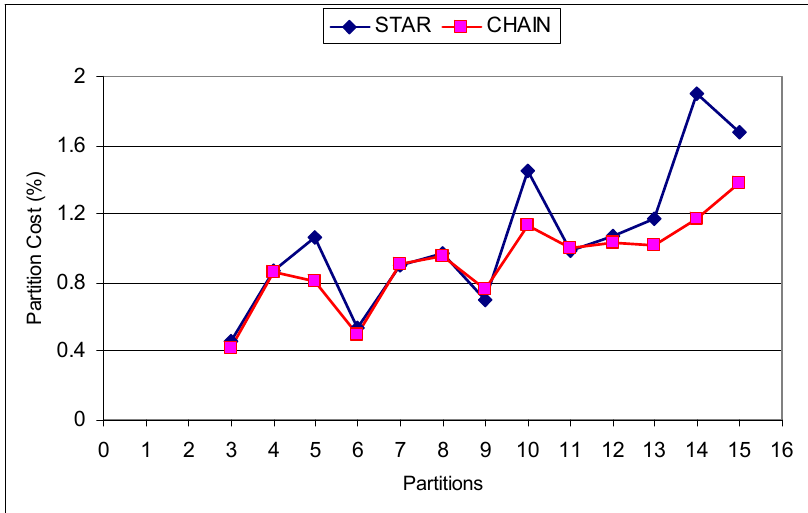
Figure 11. Partitioning cost as function of the number of equal sizes partitions, for WL2 workload using CHAIN and STAR